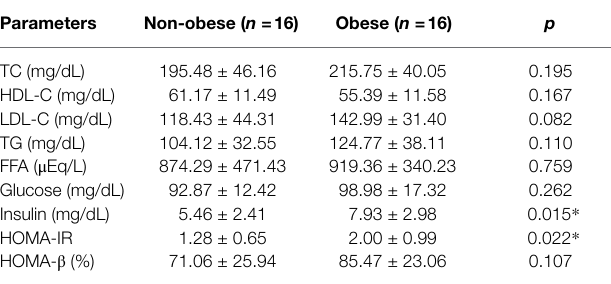
TABLE 3 | Difference in cardiometabolic parameters (mean ± SD) between non- obese and obese.